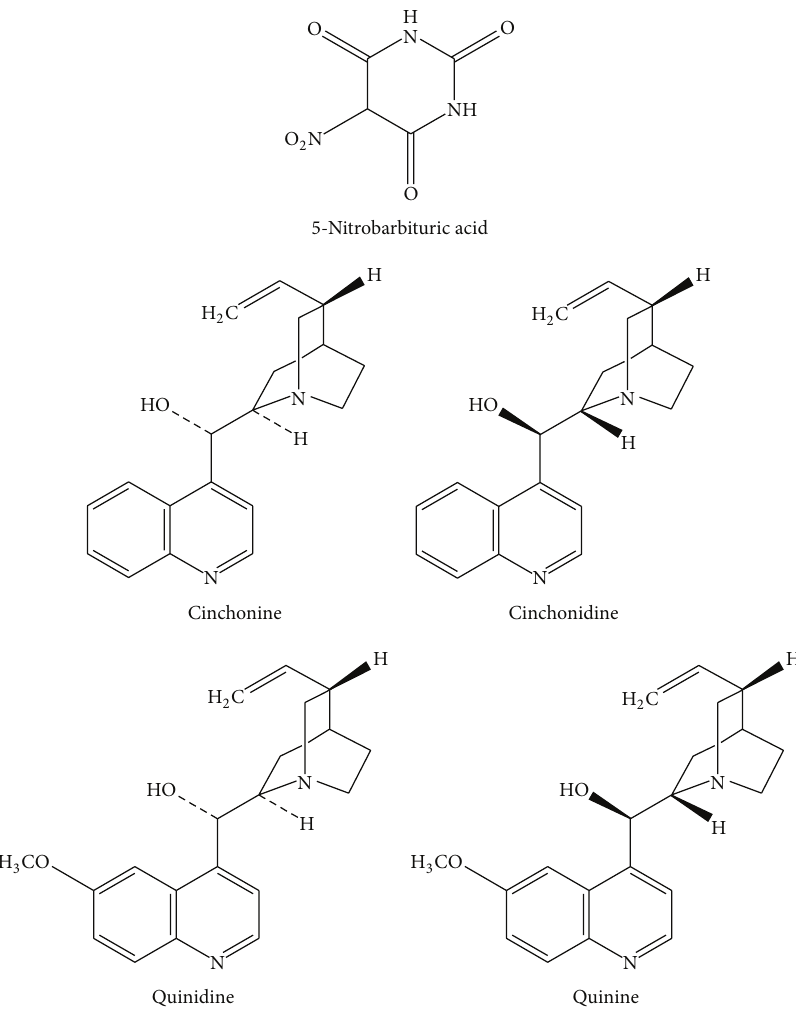
Figure 1: Structures of 5-nitrobarbituric acid and the four cinchona alkaloids used in this